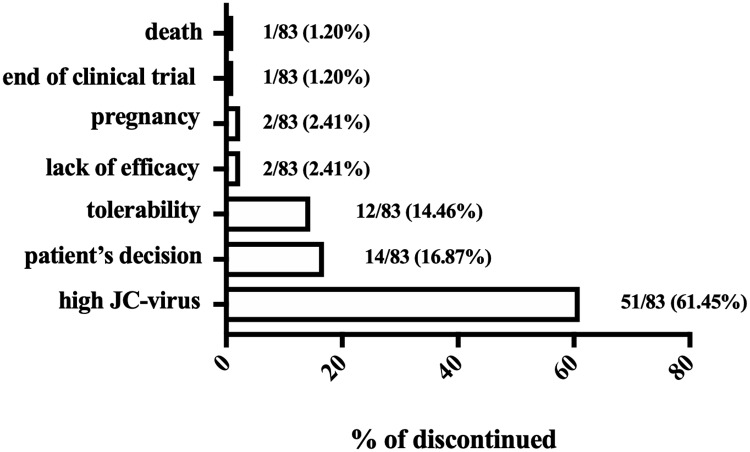
Reasons for natalizumab discontinuation.JC-virus—John-Cunningham virus.